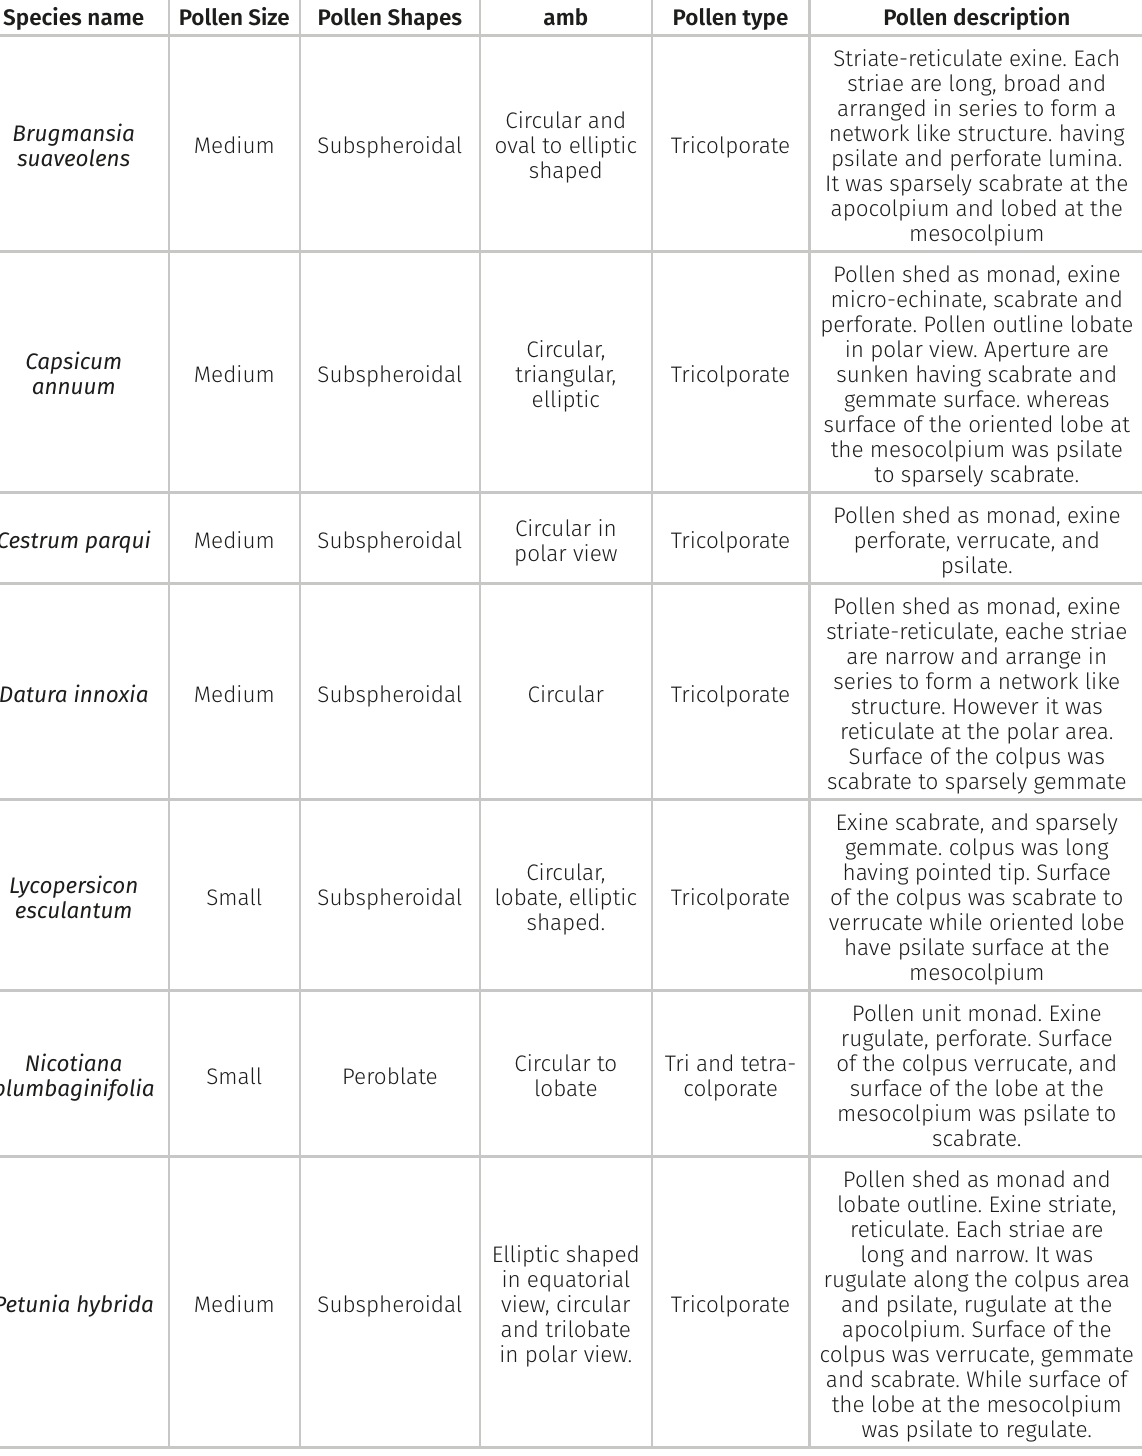
Table III. Qualitative characters for pollens of Solanaceous species from arid zone of